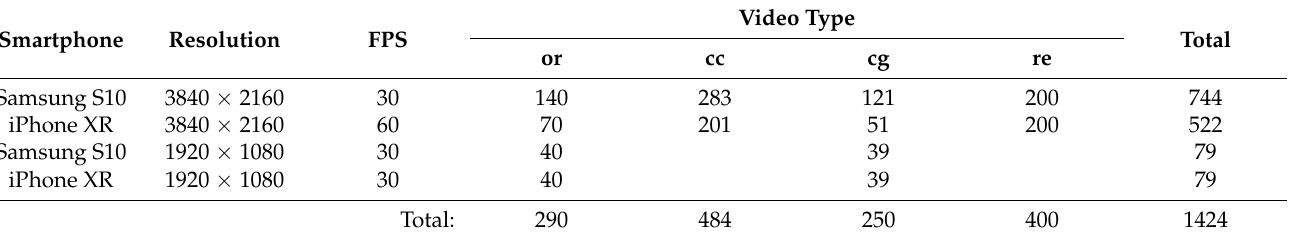
Table 4. Number of video clips by